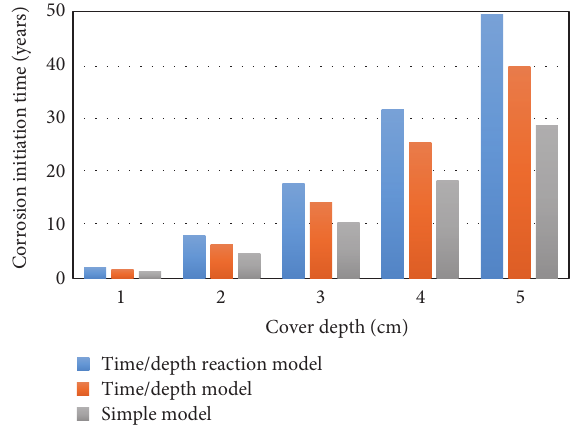
Figure 8: Comparison of corrosion initiation time by different diffusion coefficients